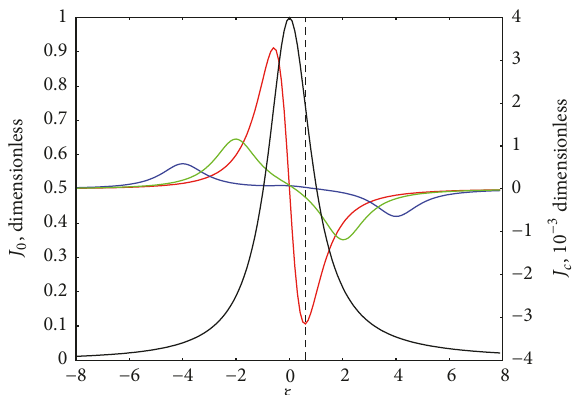
Figure 2: Direct current (solid black line, left 𝑦 -axis) and active current 𝐽 𝑐 (right 𝑦 -axis) as a function of 𝜉 = (𝜀 − 𝜀 𝑅 )/Γ in the model with monoenergetic electrons at the following frequencies: ℎ𝜔 = 0.1Γ (red line), ℎ𝜔 = 2Γ (green line), and ℎ𝜔 = 4Γ (blue line). Vertical dashed line indicates the area of maximum NDC.